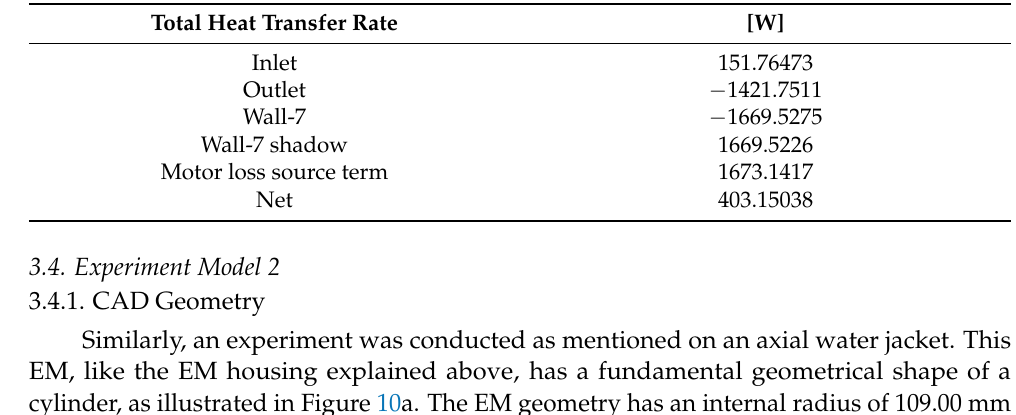
Table 2. Overall motor losses from Helical water